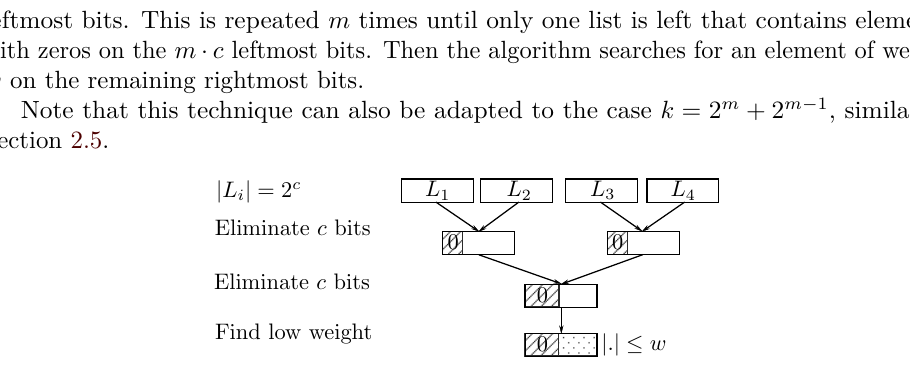
Figure 13: Match-and-Filter algorithm for k = 4